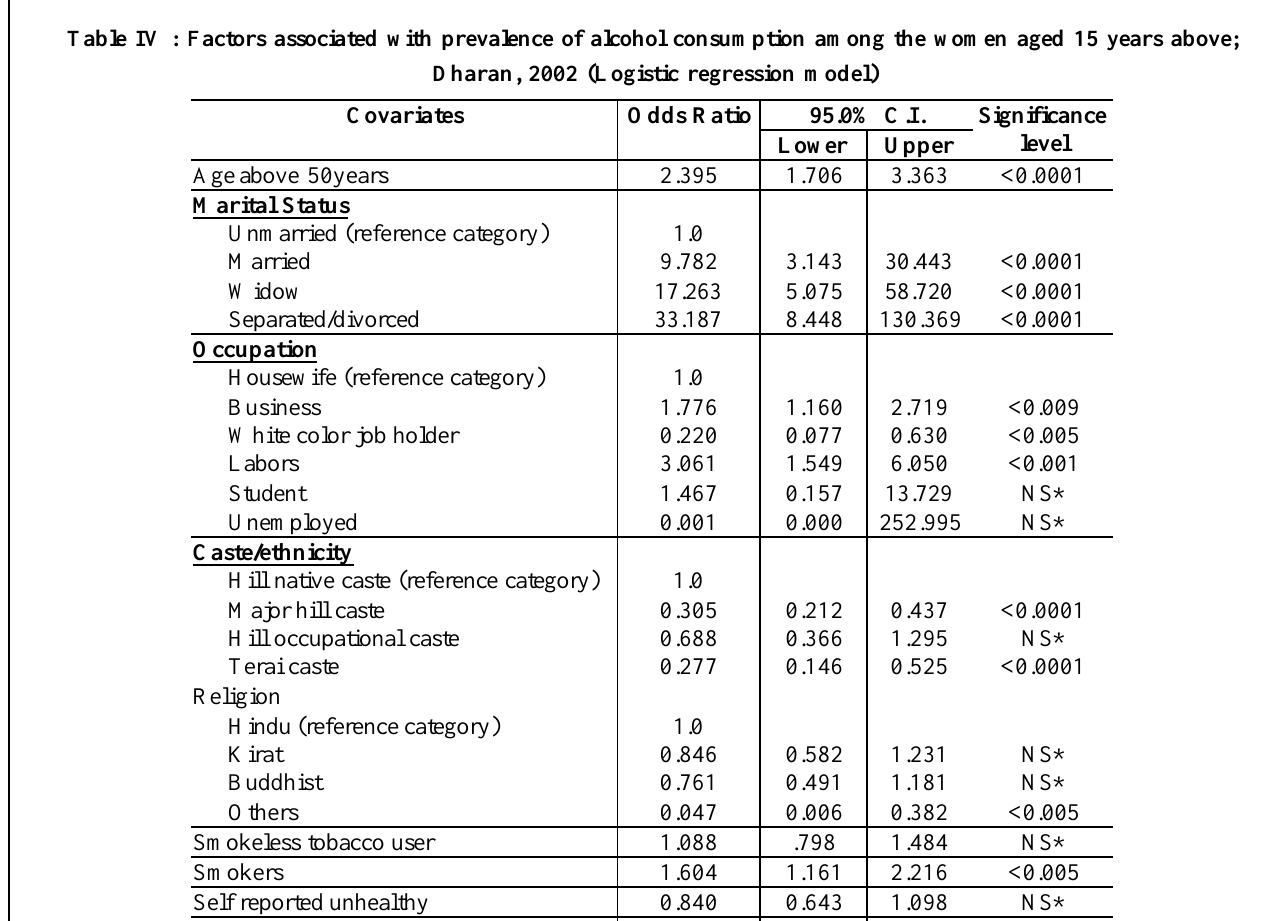
Table IV : Factors associated with prevalence of alcohol consumption among the women aged 15 years